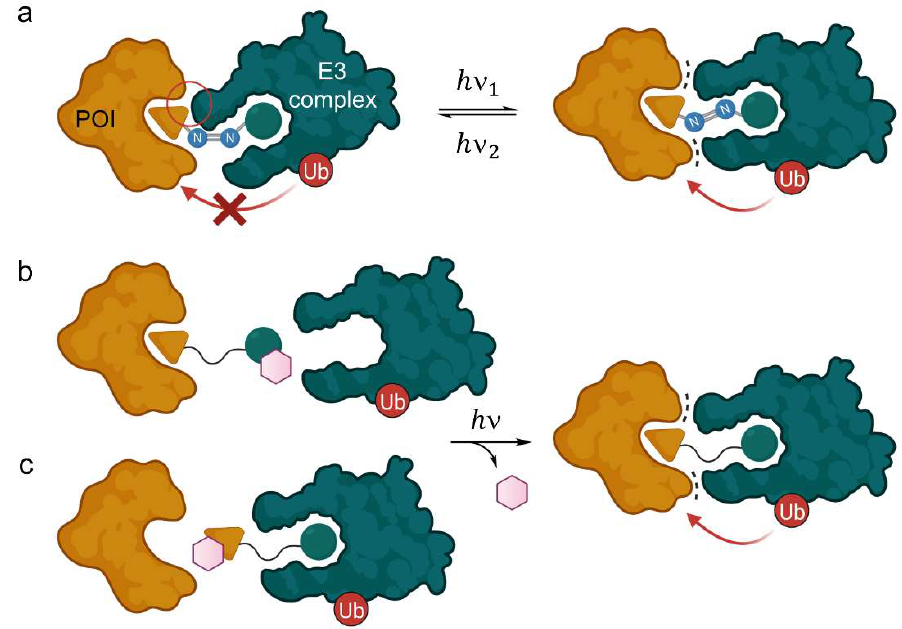
Figure 5. Light-responsive PROTACs and their mode of action. ( a ) Azo group-containing PROTACs can be irradiated to form either the E - or the Z -isomer, one of which is degrading and the other inactive, thus allowing spatiotemporal control of target protein knockdown. The distance between both ligands is significantly enhanced in the trans -configuration, where beneficial protein-protein interactions take place (dots), whereas the cis -PROTAC is too short to form the ternary complex, or vice versa . ( b , c ) PROTACs with an additional photocleavable group (purple hexagon) prevent either the E3 ligase ( b ) or the POI ( c ) from binding. Light irradiation cleaves the group irreversibly and releases the active PROTAC.